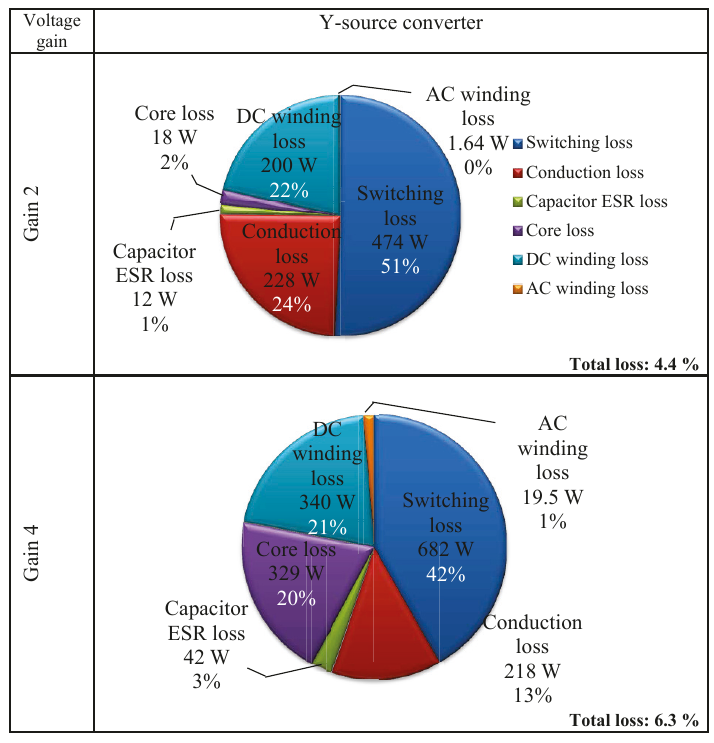
TABLE VI. Distribution of the different losses for the Y-source converter at 20 kW load power and two different voltage gain.